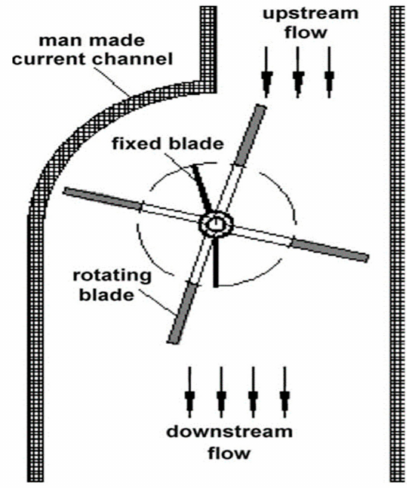
Figure 3. The geometry of vertical axis hydrokinetic turbine with fixed guiding